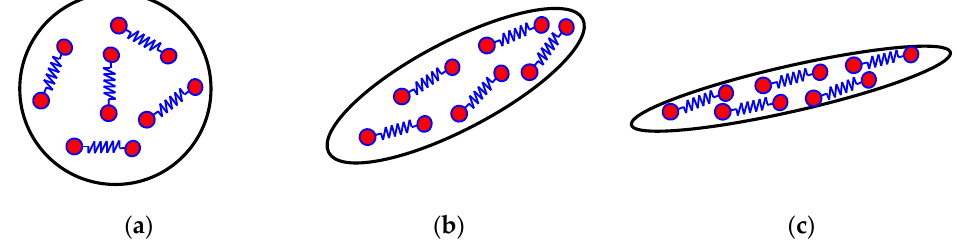
Figure 3. Schematic diagrams for conformation transformation of the macromolecules by flow: ( a ) conformation sphere without flow; ( b ) conformation ellipsoid at weak flow; ( c ) conformation pipe at strong flow.